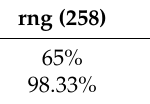
Table 12. Accuracy Table 12. Accuracy comparison.